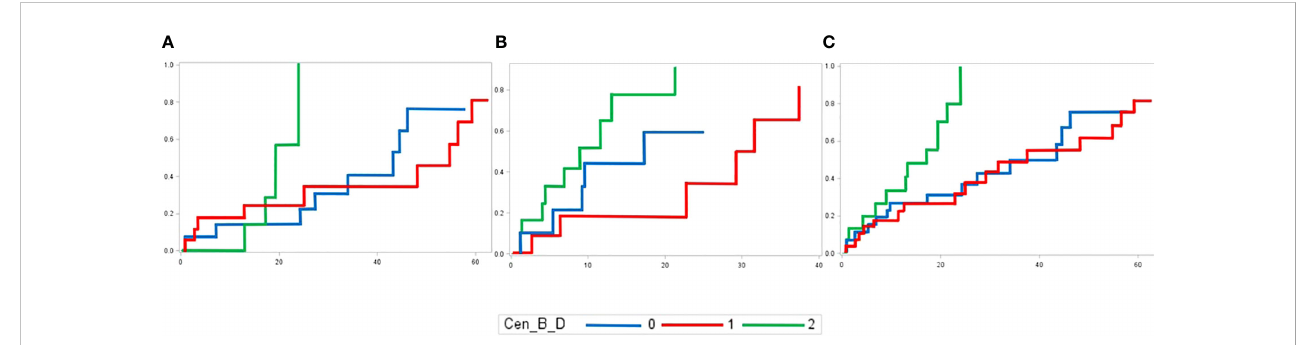
FIGURE 6 Cumulative incidences of aGVHD in (A) genoidentical, (B) haploidentical and (C) whole cohort according to the number of Cen-B motifs of the